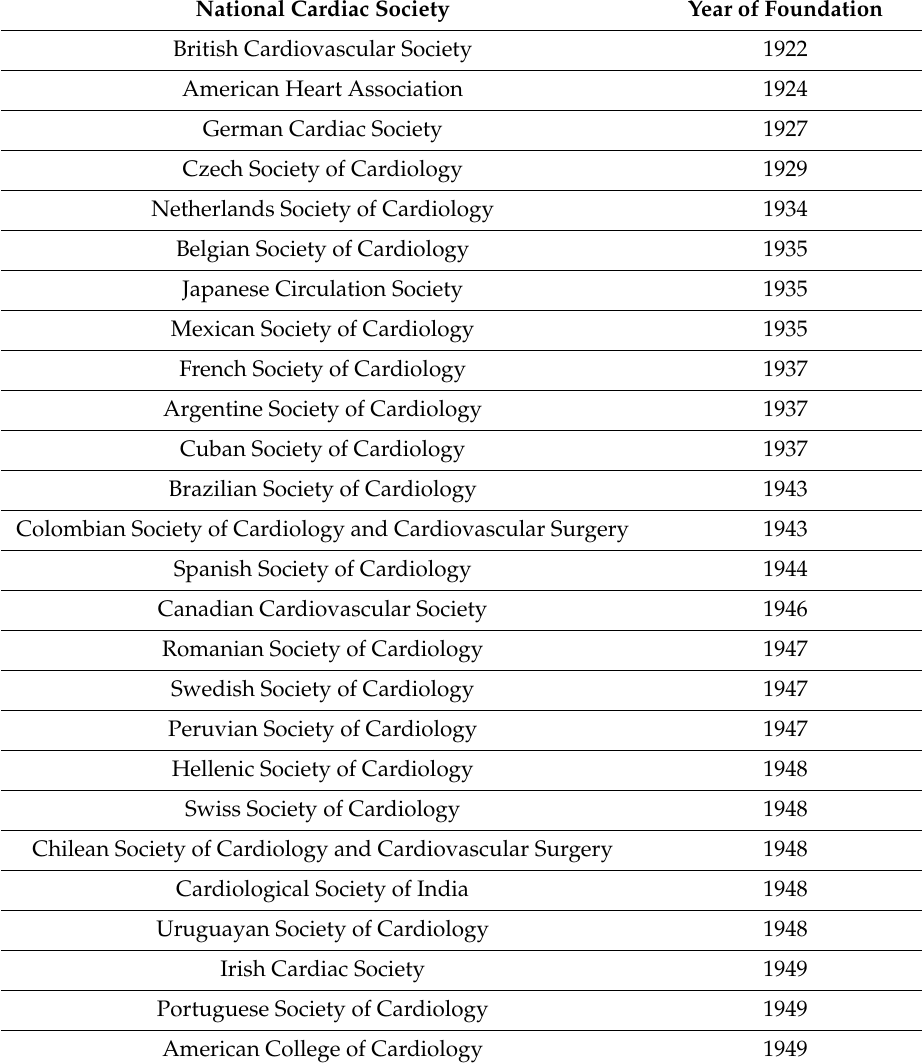
Table 1. New foundations of national cardiac societies before